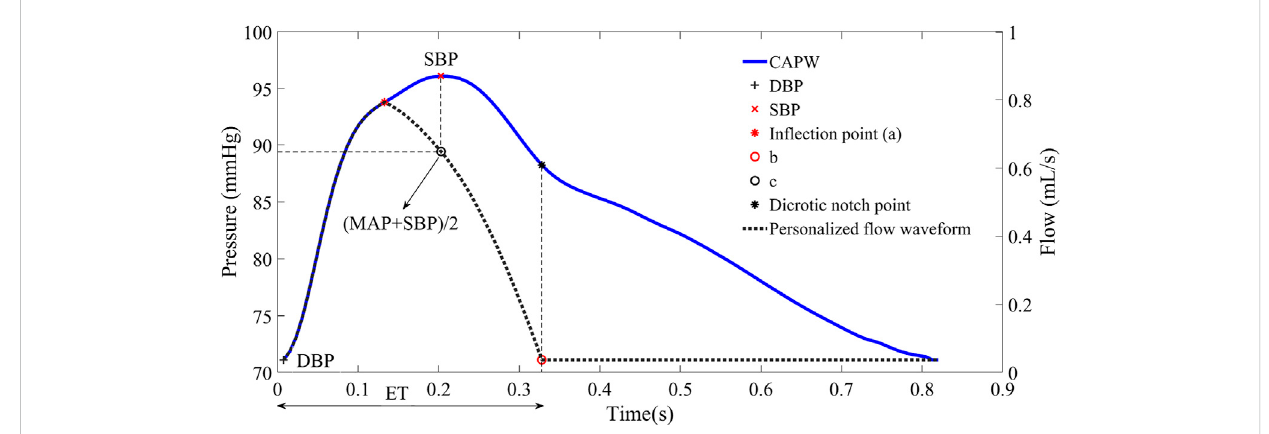
FIGURE 7 Personalized fl ow waveform constructed based on the feature points of CAPW.